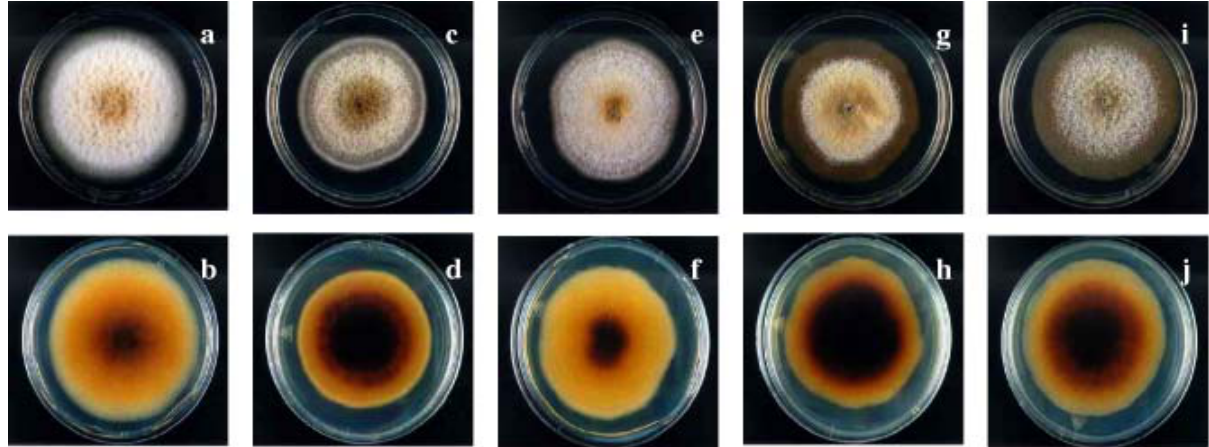
Fig. 1. Cultures of Cylindrocarpon destructans on PDA. Up: from top of colony; down: from bottom of colony. a and b, Cy2; c and d, Cy7; e and f, Cy5; g and h, Cy16; i and j, Cy68.